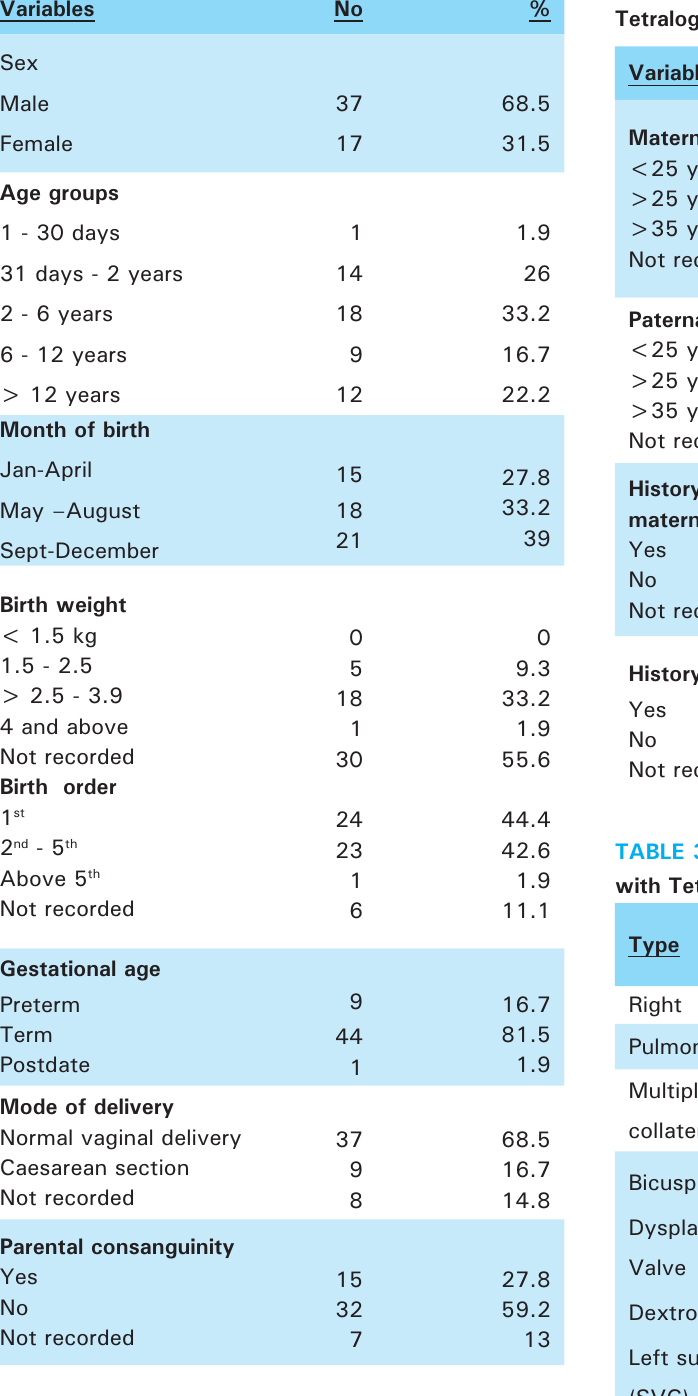
Table 2. Parental characteristics of patents with